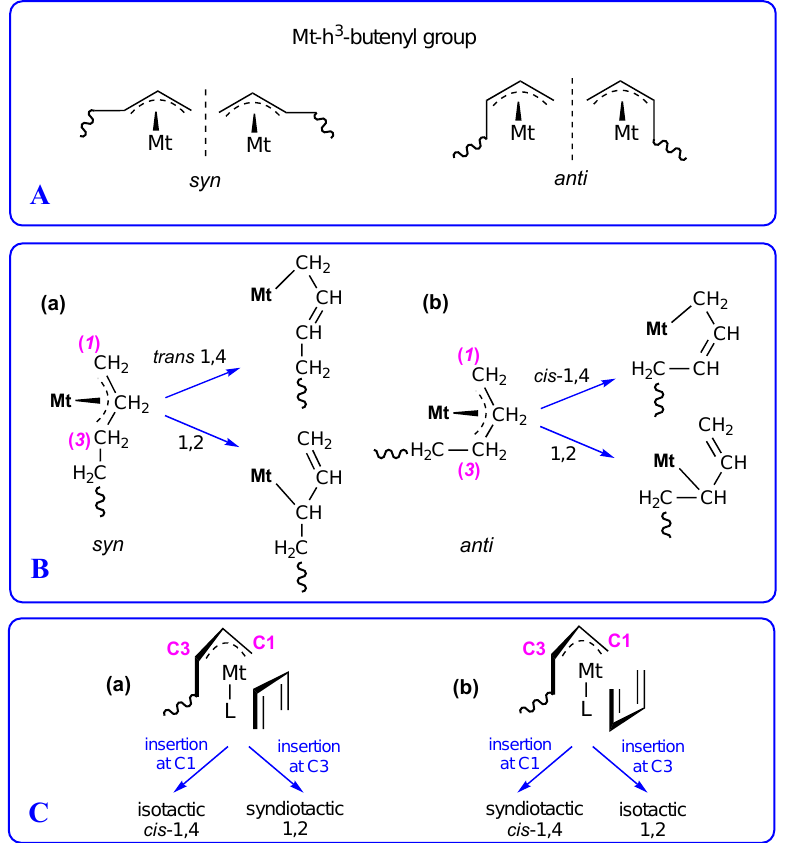
Figure 1. ( A ) Bonds between the growing chain and the transition metal of the catalyst; ( B ) formation of 1,4 vs. 1,2 monomeric units from ( a ) syn and ( b ) anti Mt-butenyl groups; ( C ) possible orientations (( a ) exo-exo and ( b ) exo-endo ) of the new incoming monomer with respect to the last-inserted unit (L is a generic ligand) and formation of cis -1,4 and 1,2 polymers having a syndiotactic or an isotactic structure.